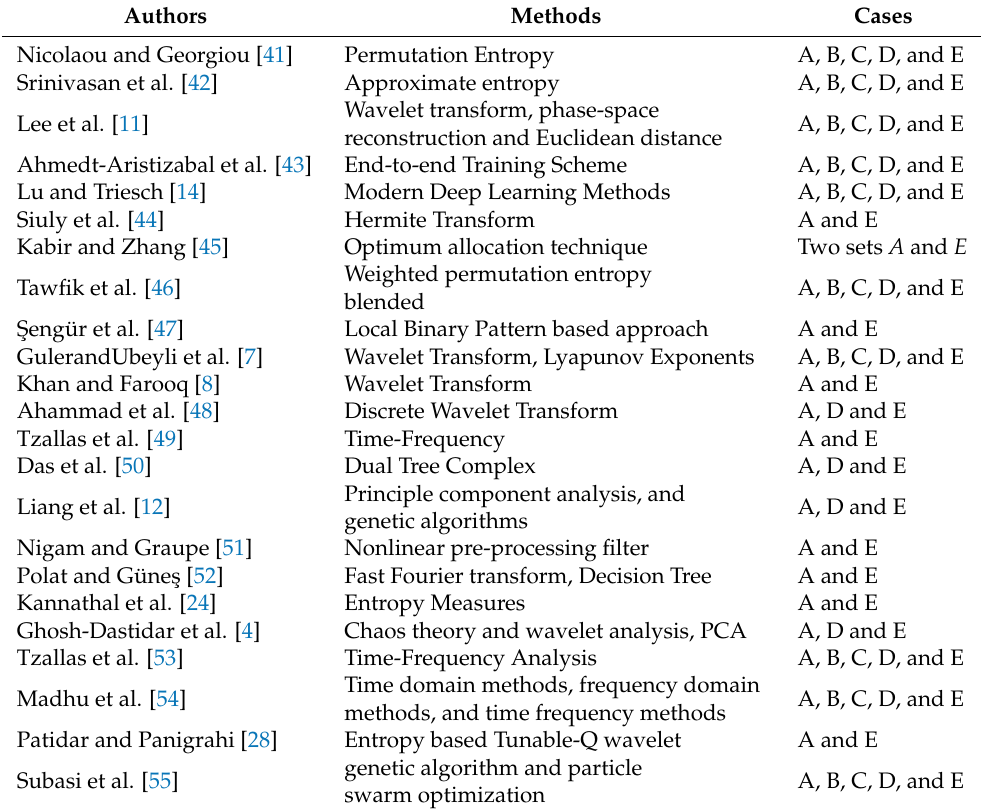
Table 1. A summary of recent seizure-detection